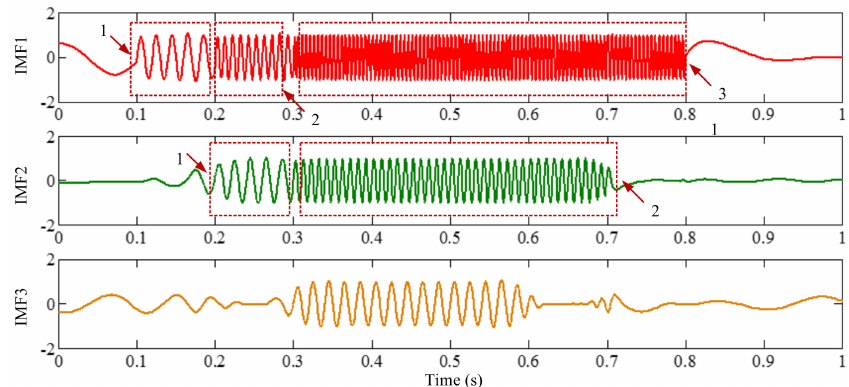
Figure 10. The waveforms of the IMFs 1–3.